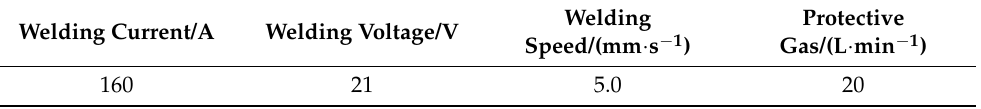
Table 2. Welding